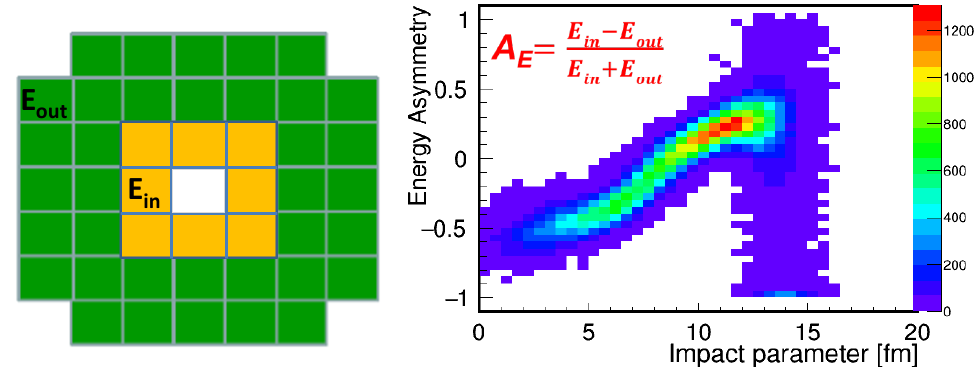
Figure 4. Left - parts of the FHCal used for the calculation of the energy asymmetry. Right- dependence of the energy asymmetry, A E on impact parameter in FHCal for Au + Au collisions at √ s NN = 5 GeV simulated with the LA-QGSM model